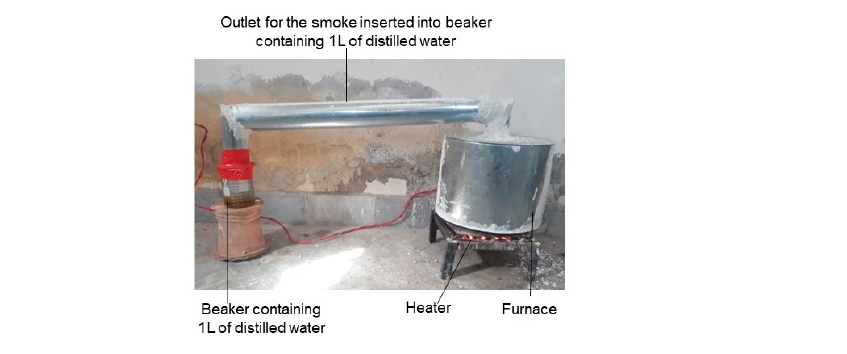
Figure 1. Preparation of plant-derived smoke solution. Plant material is burnt in the specified chamber through an electric heater. The smoke coming from burning plant material is collected through a pipe by bubbling this smoke into 1 L distilled water at the other end of pipe. All the setup is completely sealed to avoid any smoke